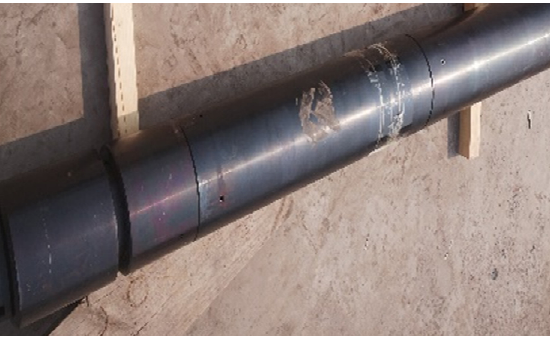
Figure 9. The prototype of the multi − source impact oscillation speed − increasing tool.